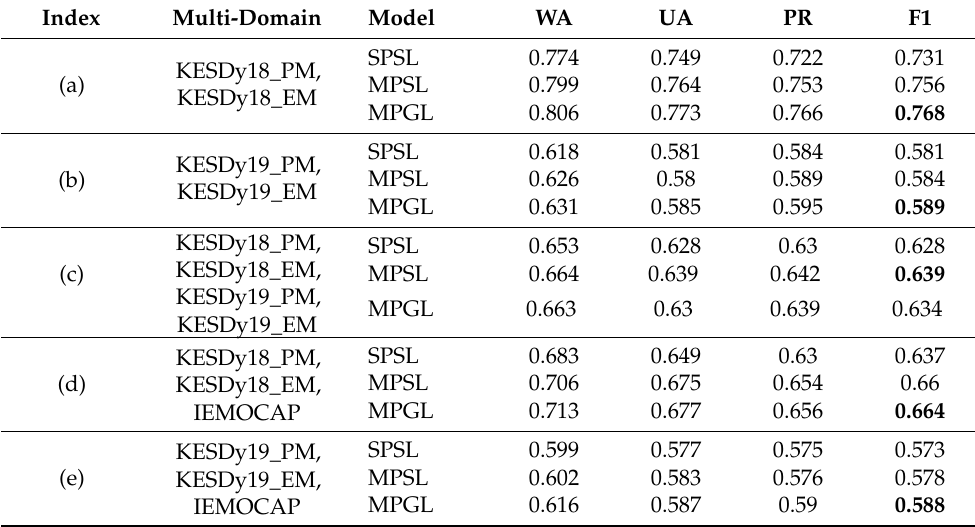
Table 7. Evaluation results of multi-domain adaptation.